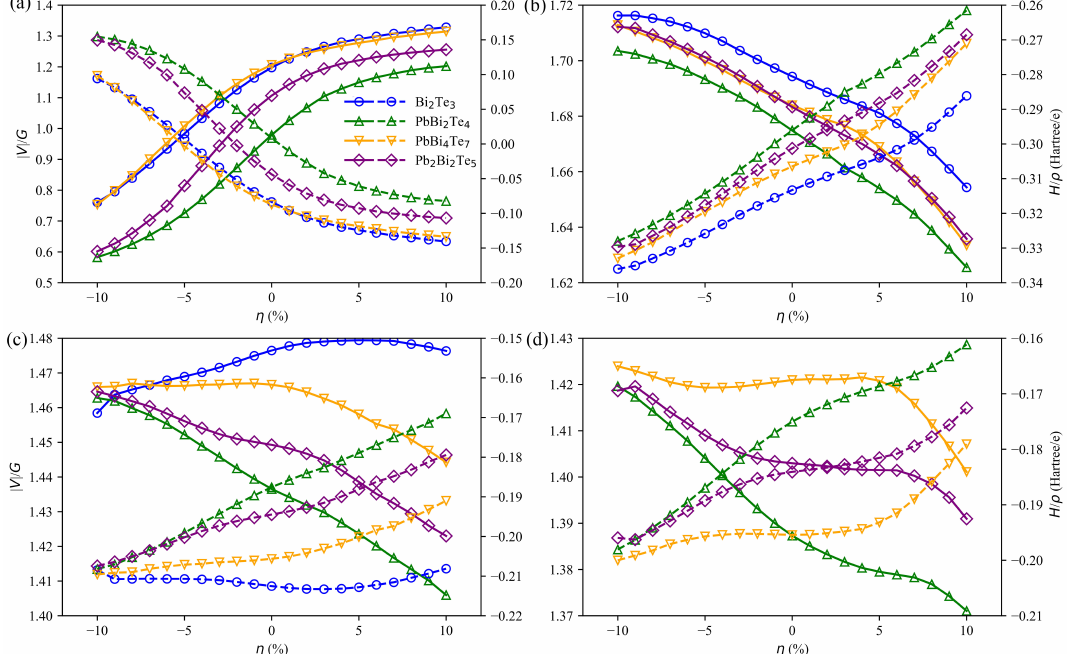
Figure 11. | V | / G (solid lines) and H / ρ (dashed lines) at various bond critical points (b1 in ( a ), b2 in ( b ), b3 in ( c ) and b4 in ( d )) for Bi 2 Te 3 , PbBi 2 Te 4 , PbBi 4 Te 7 and Pb 2 Bi 2 Te 5 w.r.t. strain. The positions of b1, b2, b3 and b4 are defined in Figure